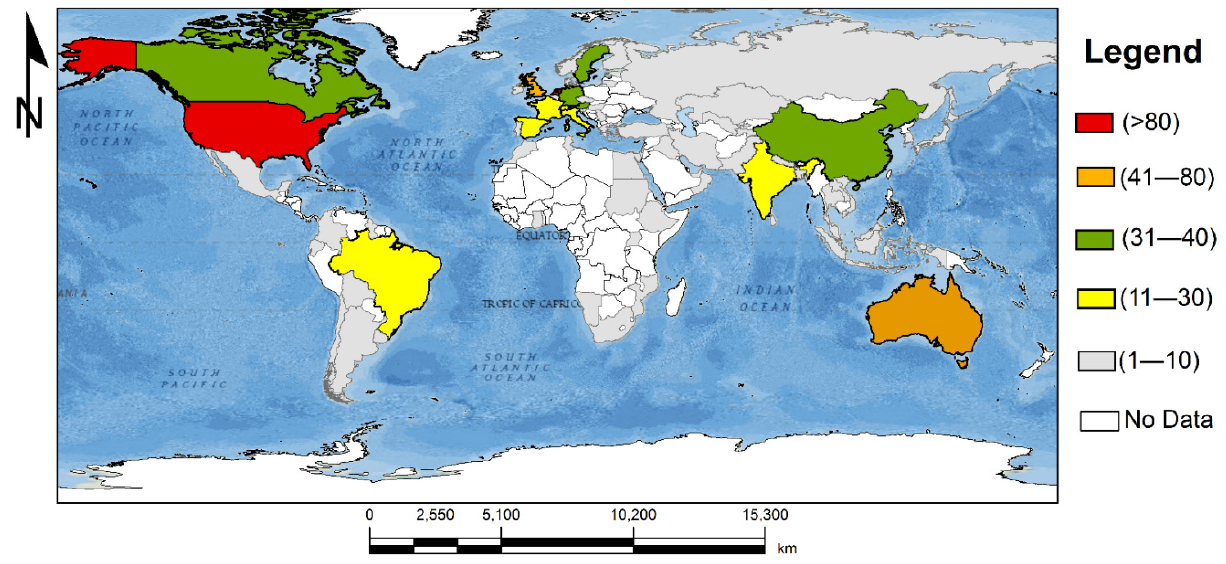
Figure 7. Countries’ contribution to socio-hydrology.